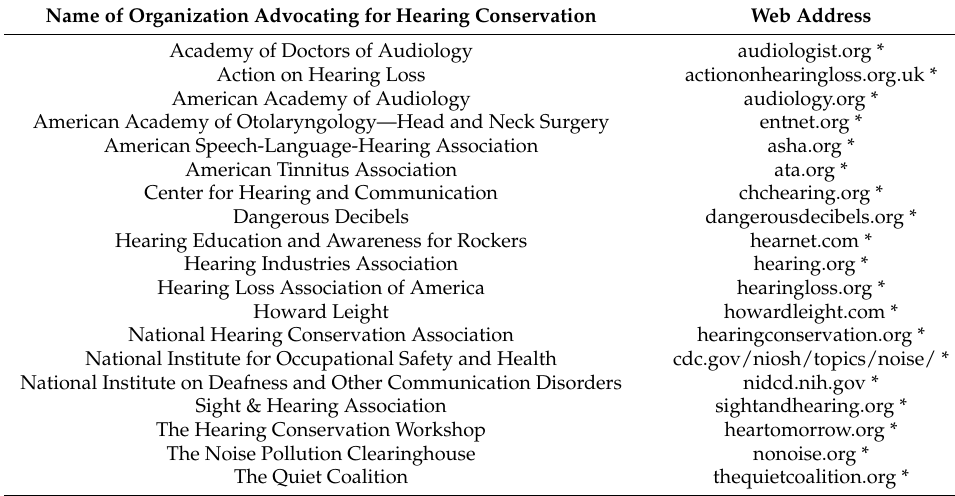
Table 1. Organizations advocating for hearing